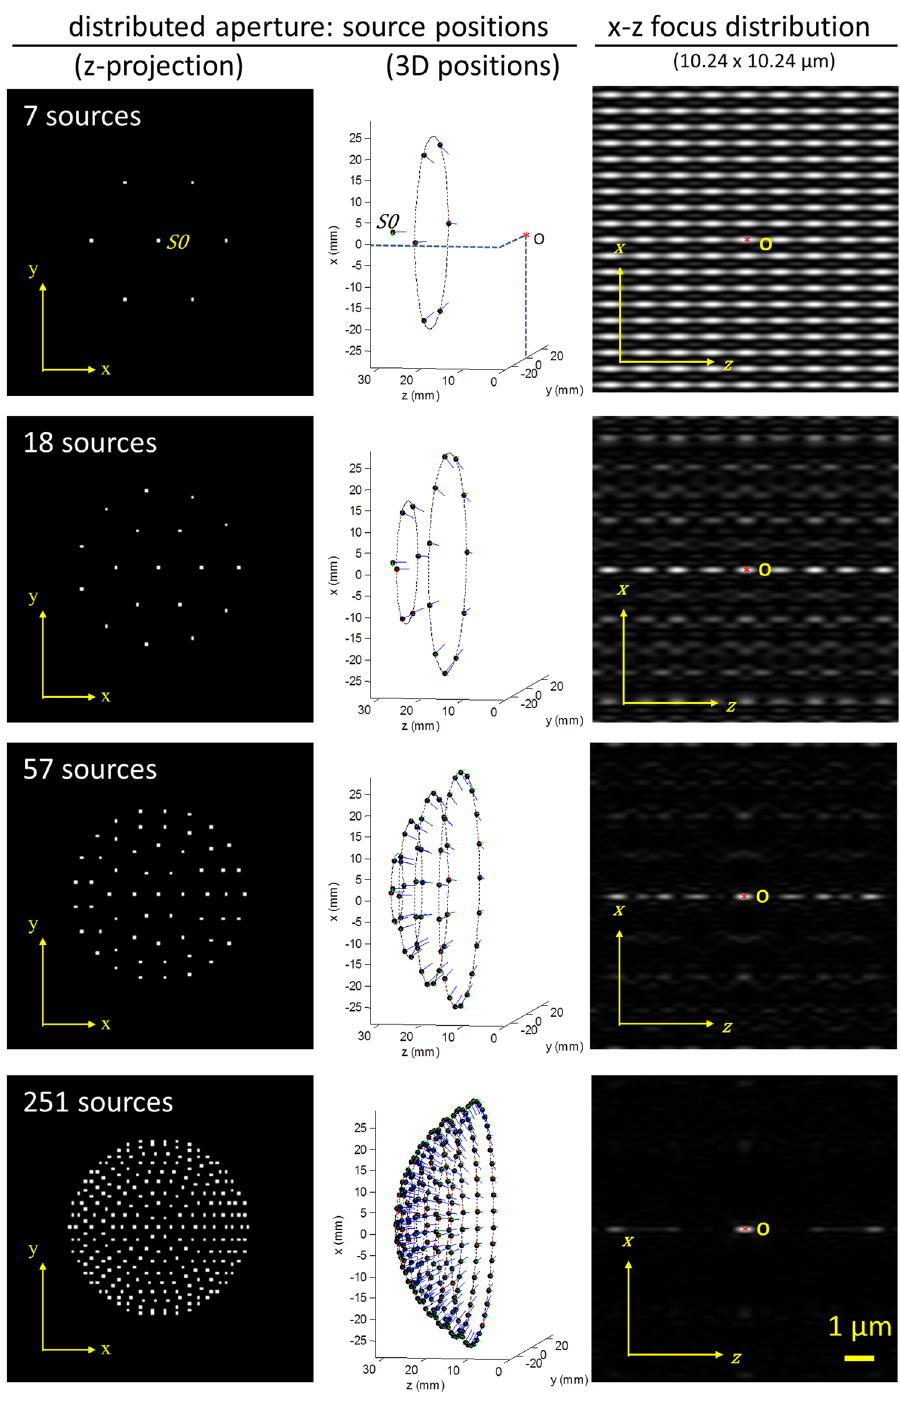
Figure 7. Arrangement of a number of coherent light sources and resulting focus intensity distribution. The light sources are arranged on a hemisphere such that the collimated light is directed towards the focal point at the origin O = (0, 0, 0). The sources have a distance d = 30mm from the origin. Note that the position coordinates can be multiplied by a constant scaling factor without changing the focusing properties as long as the beams remain collimated at the origin. Left column: z-projections of the source locations, with one central source S 0 on the optical axis (z), and the other sources spread out to have approximately equal distances on the spherical surface. Center column: 3D plot of the source locations. The light sources are arranged on concentric rings (dashed lines) around the origin, with an increasing number of sources (n = 1, 6, 12, 24, 29, 34, 39, 42, 46) with increasing ring diameter (in this example up to 28 mm). The location of the light sources is indicated by black dots, the direction of the collimated beam is indicated by a blue line. Each light source is directed towards the origin. Right column: Resulting intensity distribution in the focal region as calculated using scalar theory (see Supplementary Note 1 for a quantitative assessment of the errors resulting from the use of scalar rather than vector